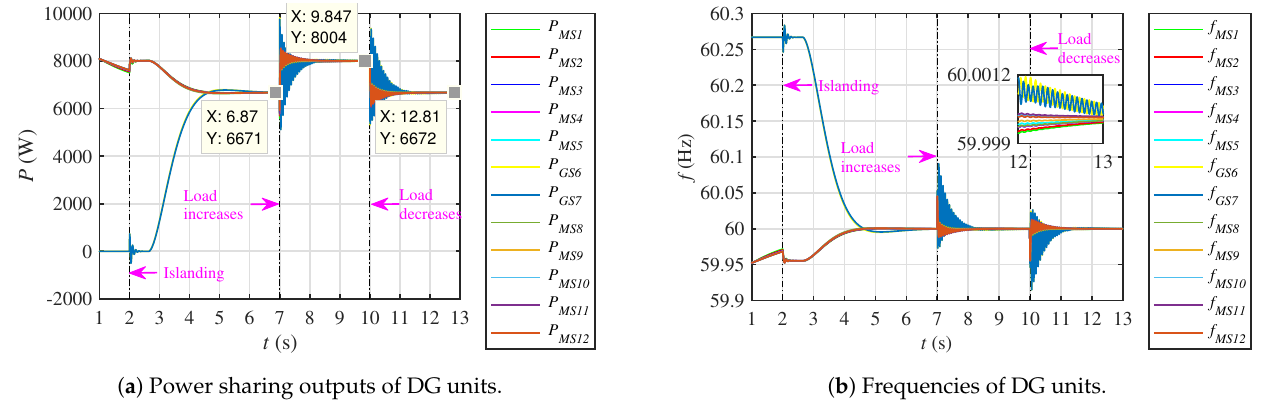
Figure 17. Power sharing outputs and frequencies of DG units for a large microgrid